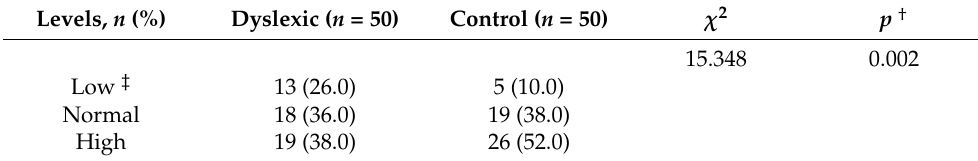
Table 3. Comparison of different self-concept levels between dyslexic group and control group. Levels, n